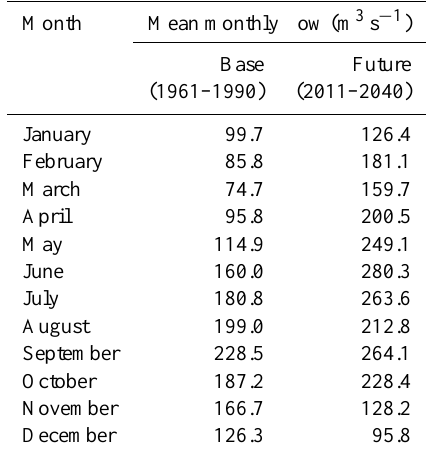
Table 1. Cyclic (seasonal) component in the base and future peri- ods: mean monthly flow in the Ijuí River basin, Santo Ângelo sta-